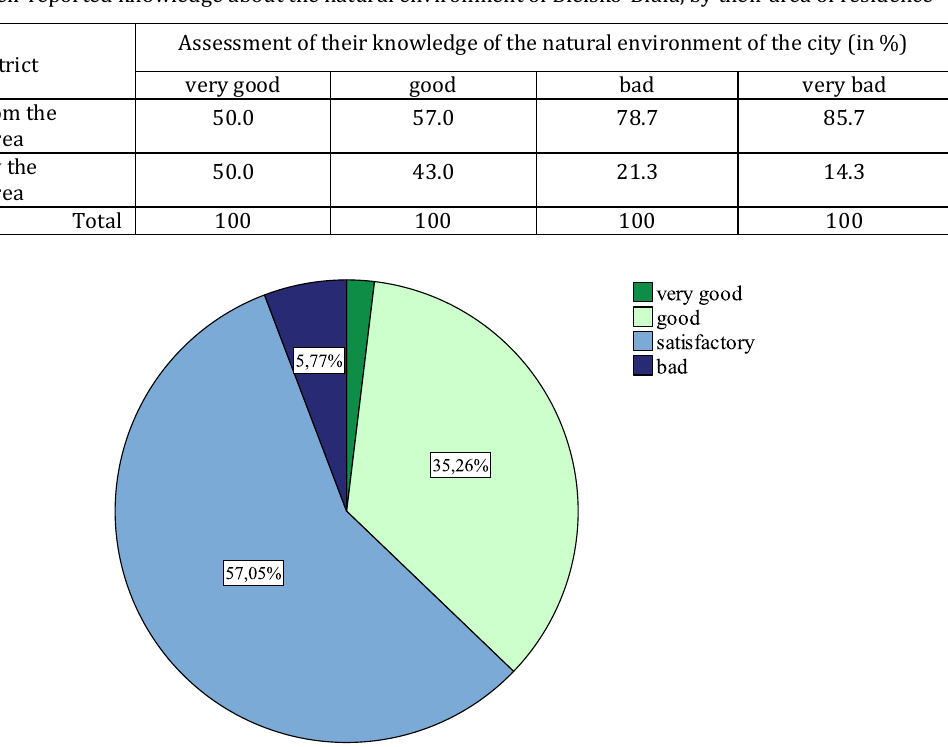
Fig. 3. Evaluation of the current state of the environment by high school students in